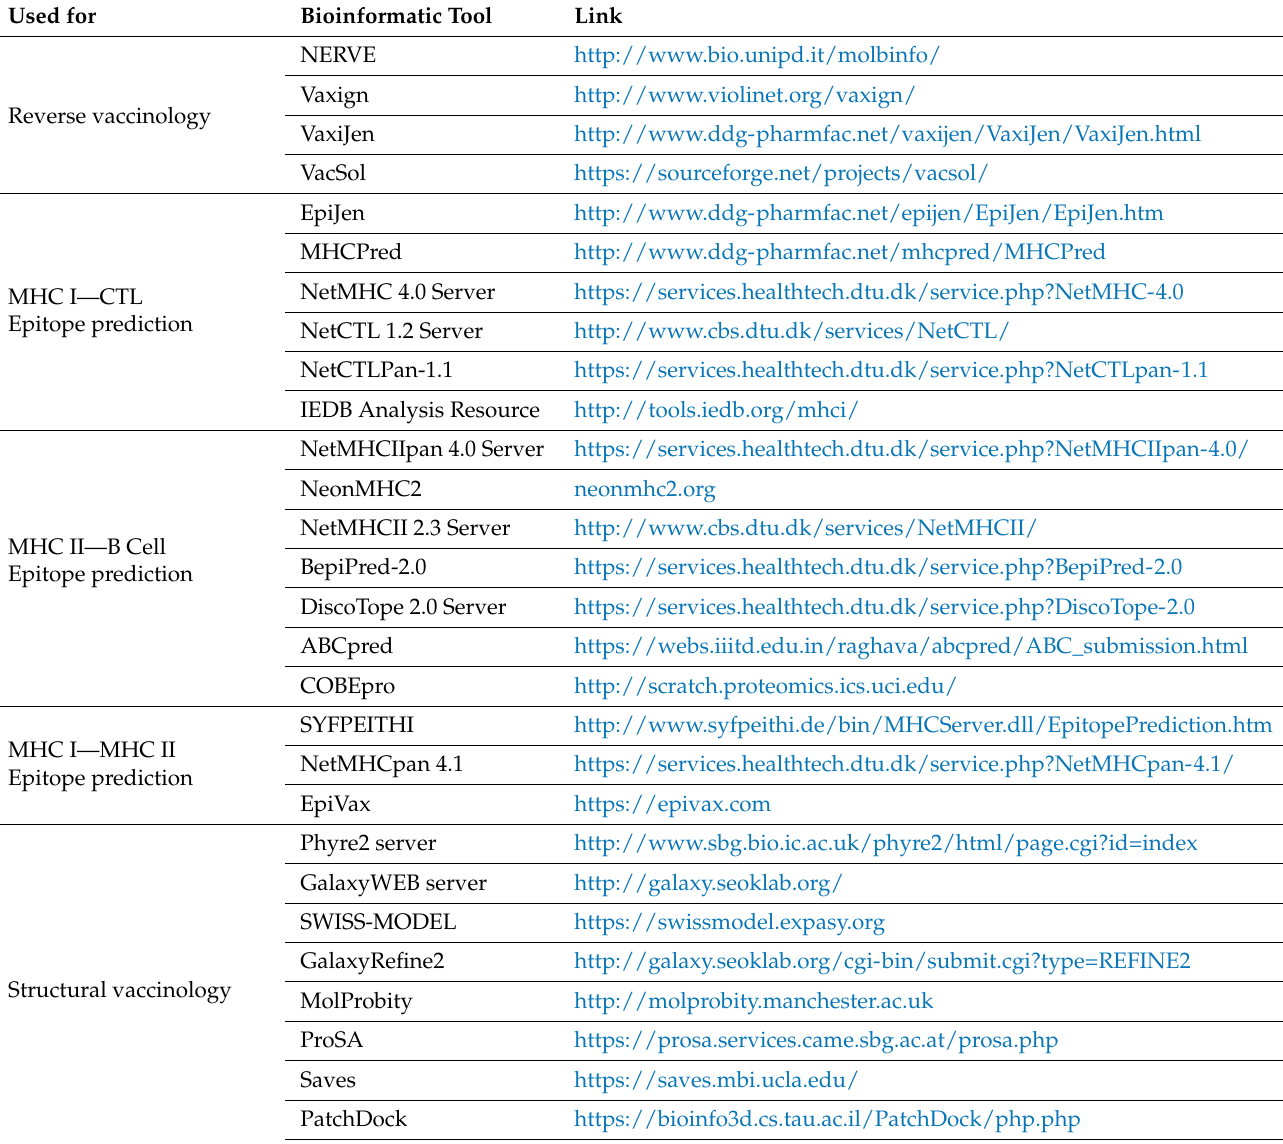
Table 1. Computational sources for vaccine development (accessed on 26 December